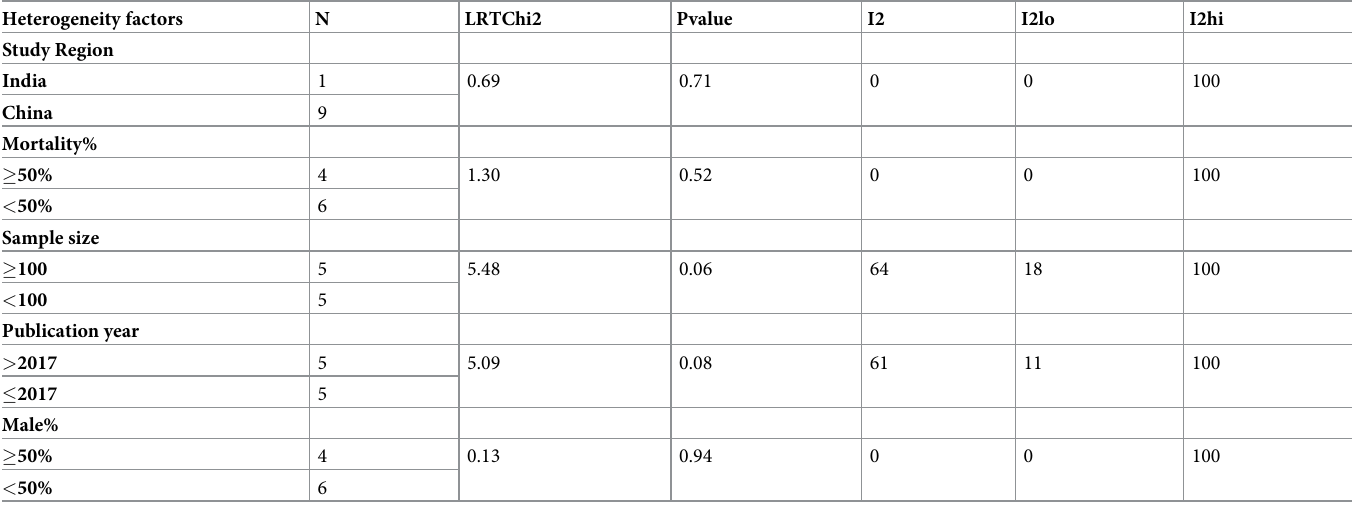
Table 2. Meta-regression analysis of potential sources of